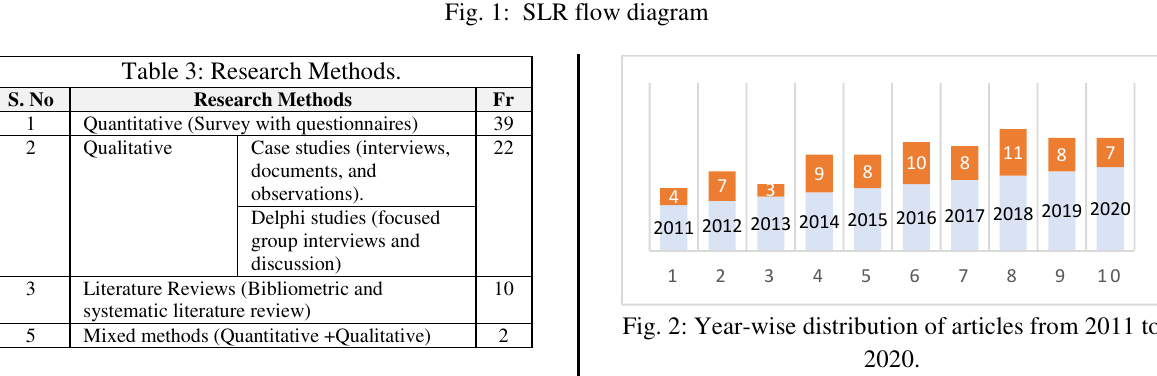
Fig. 1: SLR flow diagram